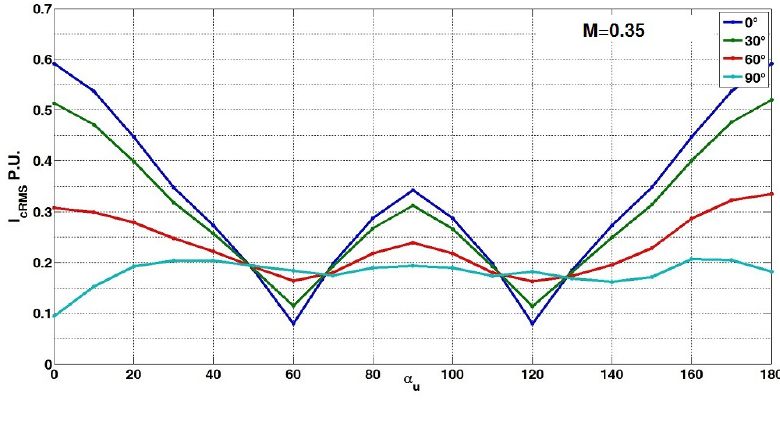
Figure 9. Simulated results triple-3-phase machine: I C carriers signals ( α u ) and different V-I phases. At M = 0.35, there is the larger variation of I C function of α u